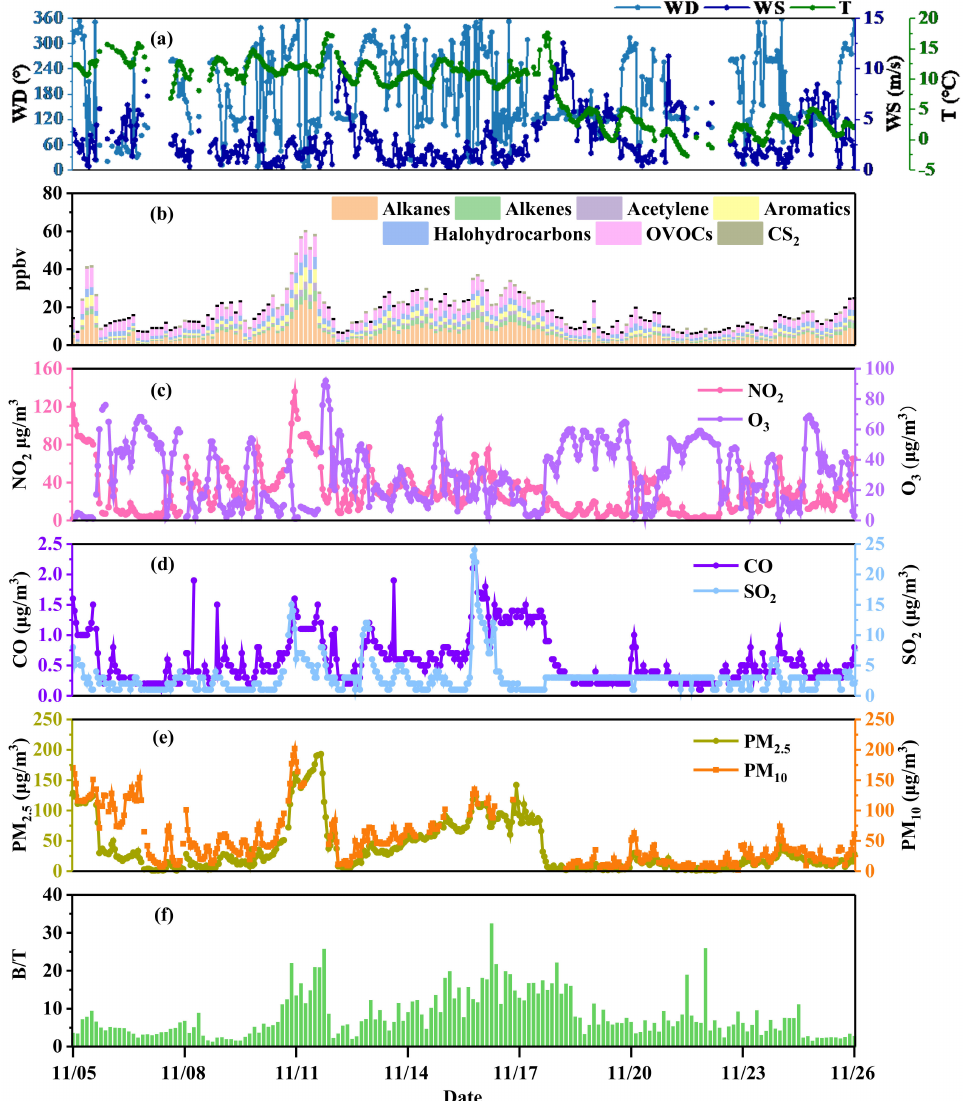
Figure 1. Hourly variations of meteorological parameters, PM 2.5 , PM 10 , and gaseous pollutants and variations of three-hour average concentrations of VOCs at UCAS, Beijing from 5–26 November 2020: ( a ) wind direction (WD), wind speed (WS), and temperature (T), ( b ) VOC concentration, ( c ) NO 2 and O 3 concentration, ( d ) CO and SO 2 concentration, ( e ) PM 2.5 and PM 10 concentration, ( f ) B/T (benzene/trimethylbenzene)